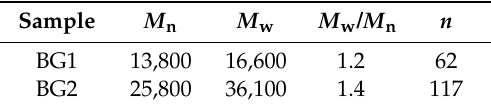
Table 1. Molecular mass characteristics of P- γ -Glu(Bzl).